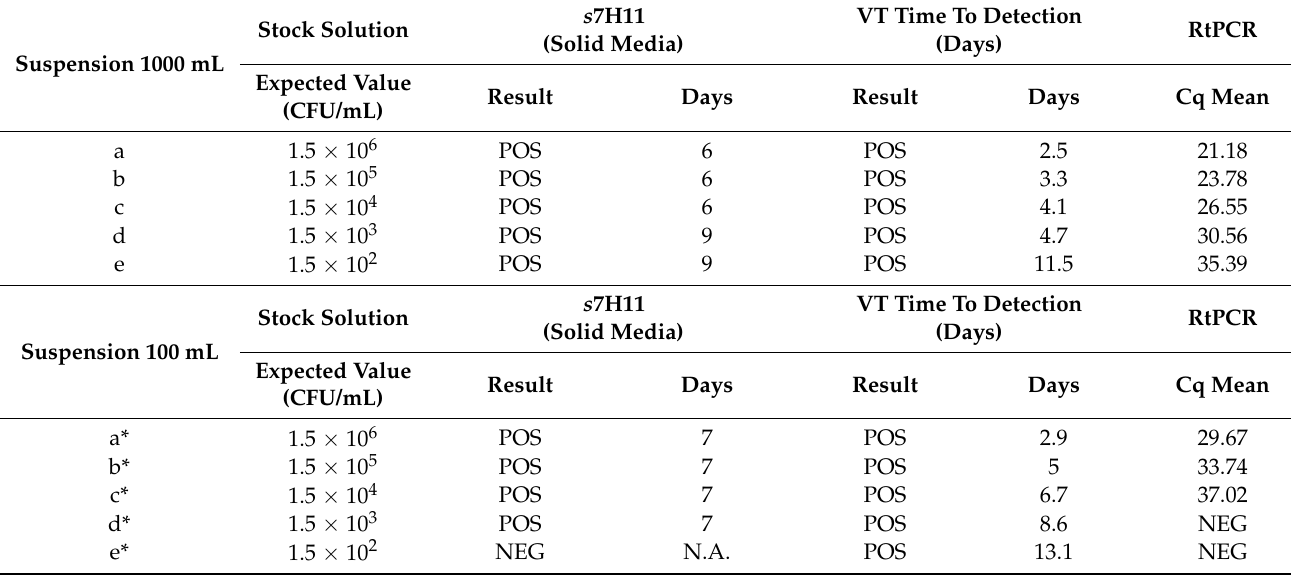
Real-time PCR on material obtained at the end of solid and the liquid culture confirmed the presence of M. chimaera